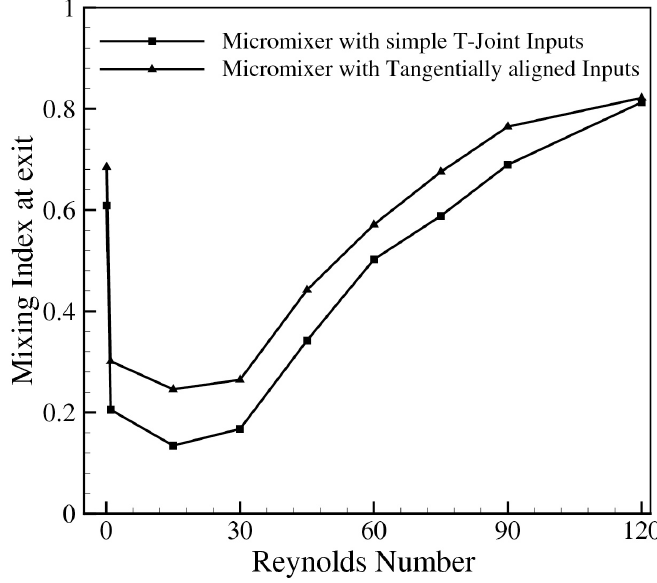
Figure 7. Variations of mixing index at the exit of micromixer with Reynolds